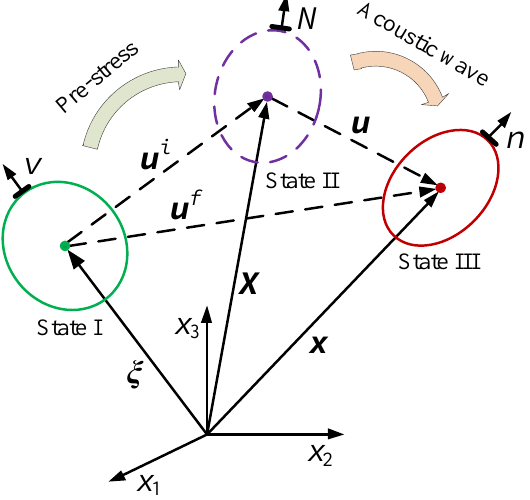
Figure 1. Coordinate system of deformed object.